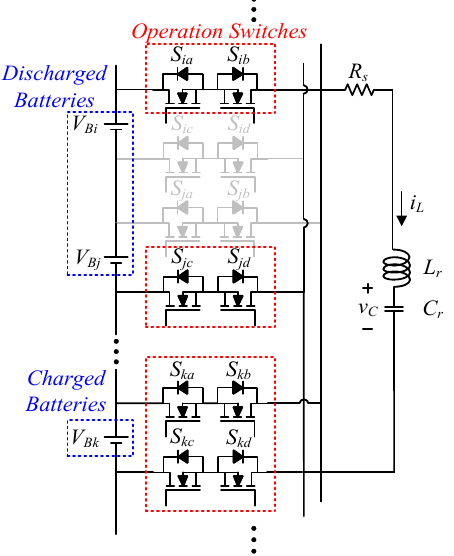
Figure 6. The circuit’s operation in enhanced mode.